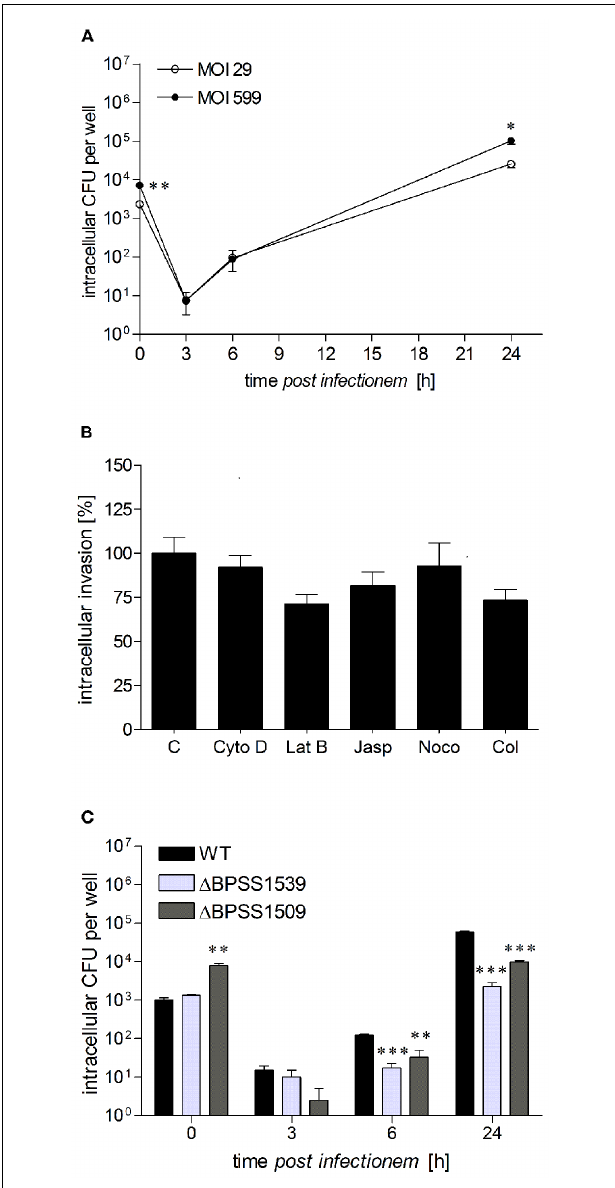
FIGURE 1 | Burkholderia pseudomallei can multiply in human hepatocytes. (A) HepG2 cells were infected with B. pseudomallei E8 at multiplicities of infection of 29:1 (opened circles) and 599:1 (closed circles), and cells were lysed at different time points after infection to determine the number of viable intracellular bacteria by plating lysates on Mueller–Hinton agar. (B) Invasion of B. pseudomallei in HepG2 cells at a MOI of ∼ 400:1 in the presence of inhibitors of actin filaments, including cytochalasin D (CytoD, 1 μ M), latrunculin B (LatB, 0.1 μ M), and jasplakinolide (Jasp, 0.5 μ M) as well as inhibitors of microtubules, including nocodazole (Noco, 10 μ M) and colchicine (Col, 5 μ M). Invasion of B. pseudomallei in the absence of an inhibitor was set to 100%. (C) HepG2 cells were infected with either B. pseudomallei wild-type (WT),T3SS-3 mutant Δ BPSS1539, or T6SS-1 mutant Δ BPSS1509 using a MOI of ∼ 40:1, and intracellular replication was monitored as above. Data are presented as mean with SEM of triplicate determinations. One representative experiment out of three independent experiments is shown. Statistical analyses were performed using a Student’s t -test (* p < 0.05, ** p < 0.01, *** p < 0.001).